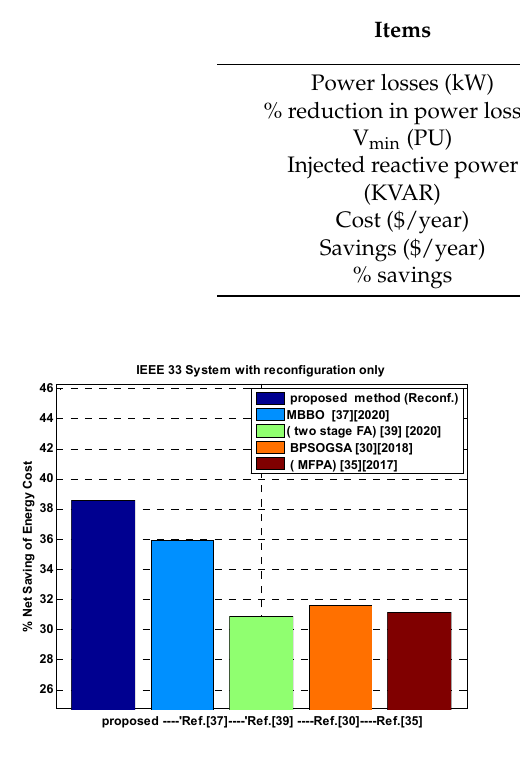
Table 6. IEEE 33 system with reconfiguration and capacitor allocation. Table 9. IEEE 119 system with reconfiguration and capacitor allocation.